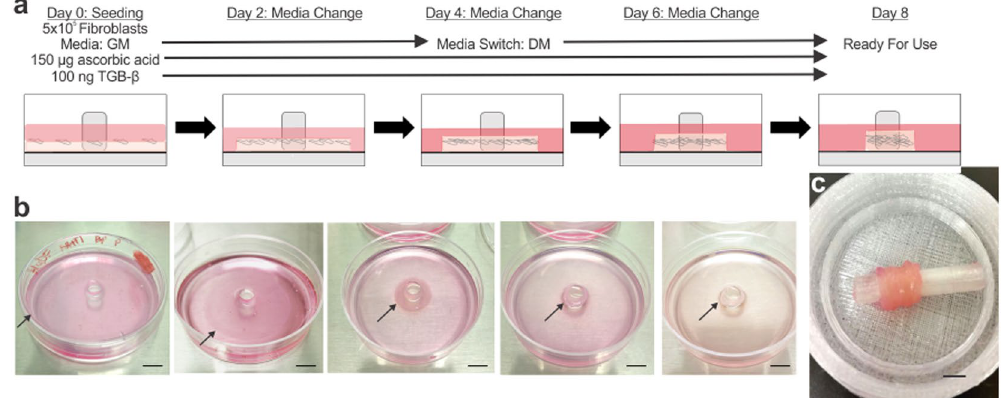
Figure 1. Optimized protocol for creating the engineered tunica adventitia. ( a ) Adventitia ring formation schematic showing the seeding density per 60 mm plate, media type and cytokine induction protocol. The hydrogel was added to custom-made plates with a bottom hydrophobic polymer coating and centrally placed posts. Human fibroblasts were then seeded in growth media (GM) and supplemented with ascorbic acid and TGF- β . On day 2, the media was changed with GM, and on days 4 and 6 media was switched to differentiation media (DM). Collagen production was enhanced by supplementing the media with both ascorbic acid and TGF- β at every media change. By day 8, the rings were ready for use. ( b ) Images of the adventitia rings self- organizing over the course of 8 days. Black arrows indicate the edge of cell sheet + hydrogel in the stages of the formation process from monolayer to ring (left to right). Scale bars = 1 cm. ( c ) Image of an adventitia